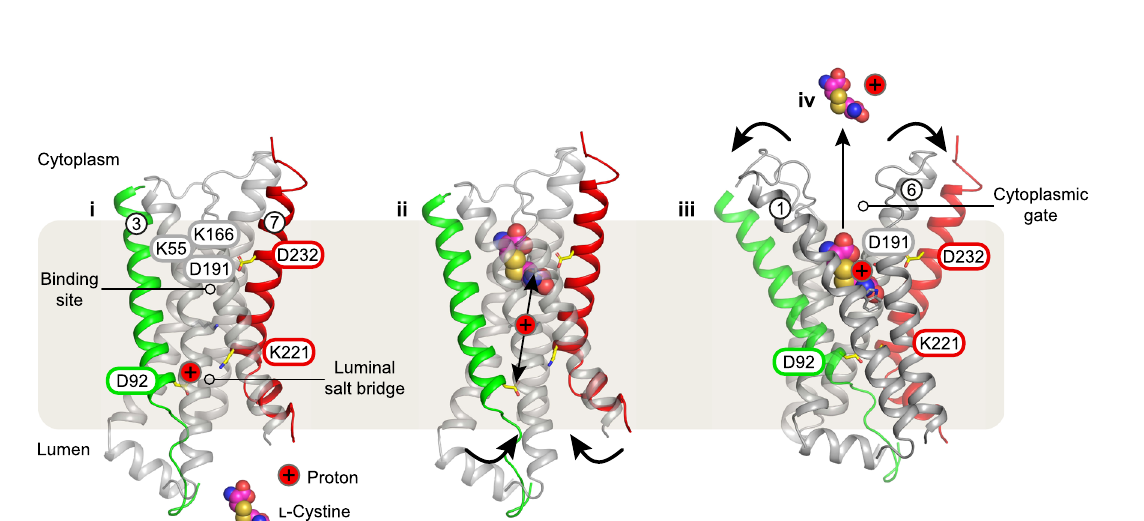
Fig. 5 | Structural context of cystinosis-causing mutations. a A subset of the missense mutations that localise to the cytoplasmic and luminal gates or binding site mapped onto the AlphaFold2 model of human cystinosin. Mutations are coloured according to the severity and onsetofdisease. Arrows indicate structural